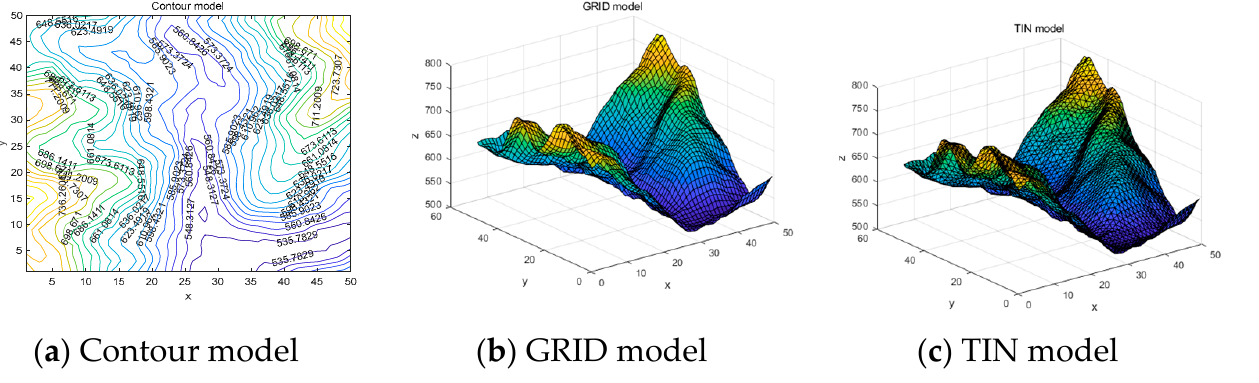
Figure 1. Contour model, GRID model, TIN model.